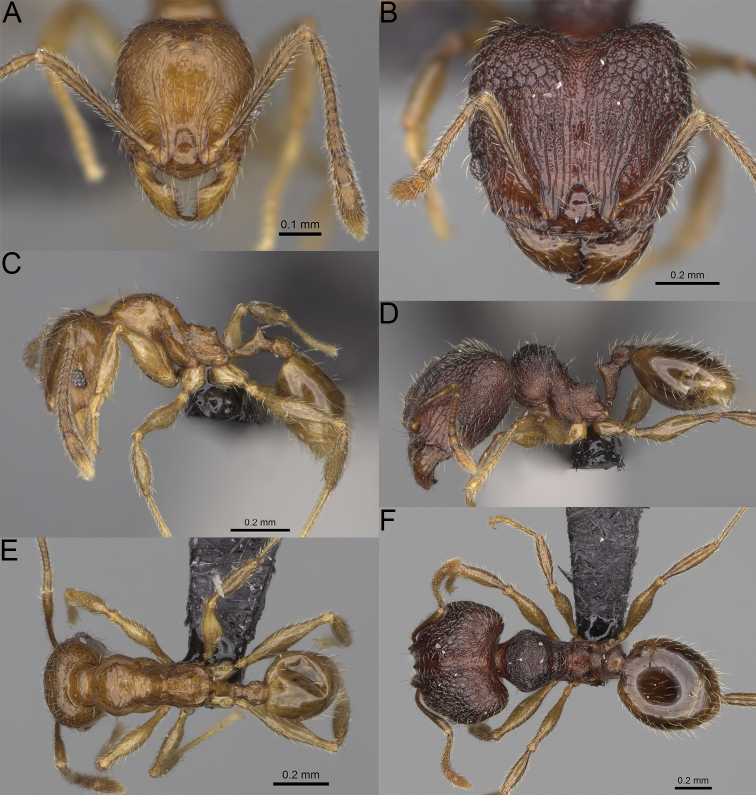
Pheidole
midongy sp. nov., full-face view (A), profile (C), and dorsal view (E) of paratype minor worker (CASENT0923275) and full-face view (B), profile (D), and dorsal view (F) of holotype major worker (CASENT0119419).